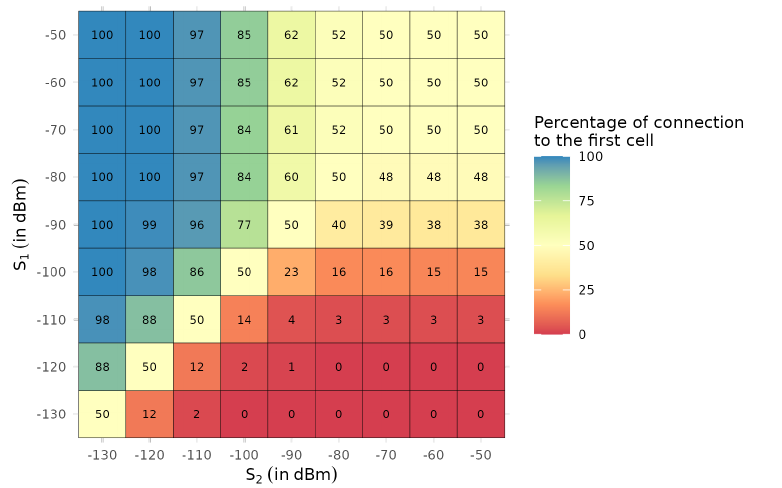
Figure 5: Percentages of connection to the first cell according to the signal dominance model (with parameters S steep = 0 . 2 and S mid = 92 . 5